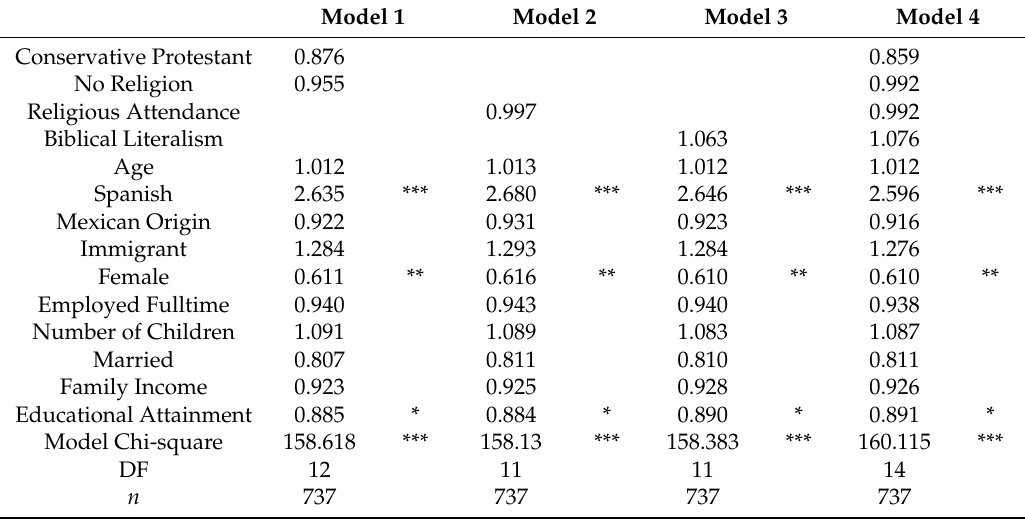
Table 3. Odds Coefficients of Ordered Logit Models Predicting Gender Essentialism: ‘Women Are Better Than Men at Taking Care of Young